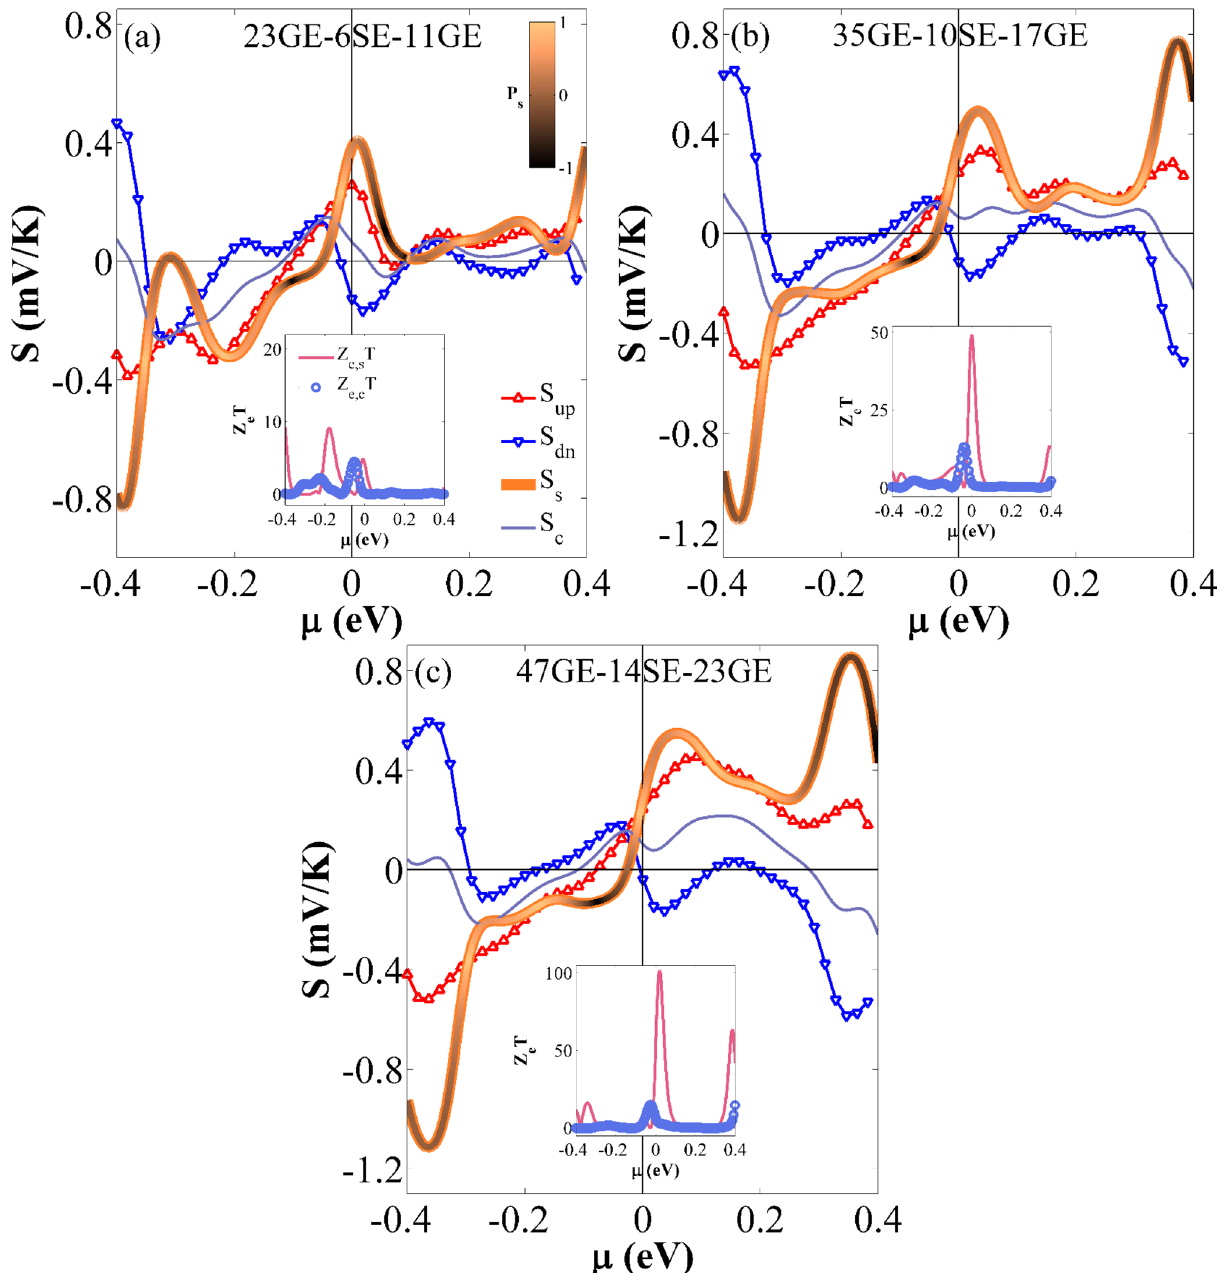
Figure 5. The S up , S dn , S s , and S c against µ at room temperature for ( a ), ( b ), and ( c ) 23GE-6SE-11GE, 35GE-10SE-17GE, and 47GE-14SE-23GE configurations, respectively. S S color varies based on Seebeck polarization ( P s ) value. The insets show the Z e, s T and Z e, c T as a function of µ The effect of DV orientation on spin caloritronics. In order to achieve complete spin-dependent ther- moelectric properties of the step-like GSNR junctions, a set of DVs with three different orientations in the 47GE-14SE-23GE (i.e., DV1, DV2, and DV3) is created and are analytically assessed 78,111 (see Fig. 1c). The varia- tion of I up and I dn against T R for DV1, DV2, and DV3 cases and ∆ T = 40 K are displayed in Fig. 6. I up and I dn values for no vacancy (NV) defect configuration are also plotted for the sake of comparison. As shown in the inset of Fig. 6a, the spin and charge transporting channels are almost closed for the NV and DV3 cases for the entire tem- perature ranges. In contrast, the other cases (i.e., DV1 and DV2) respond as an insulator for T R < 40 K. In DV1 and DV2 cases, I dn almost remained unchanged and equal to zero for the entire range of temperatures, while I up is significantly increased as T R exceeds 40 K. This confirms that the SFE is along with the spin switching effect in these cases, and occur only due to the temperature gradient with no back gate voltage. The NDTR phenomenon occurs for the latter two cases. For each case, I up absolute value also increases by T R , while their flowing directions